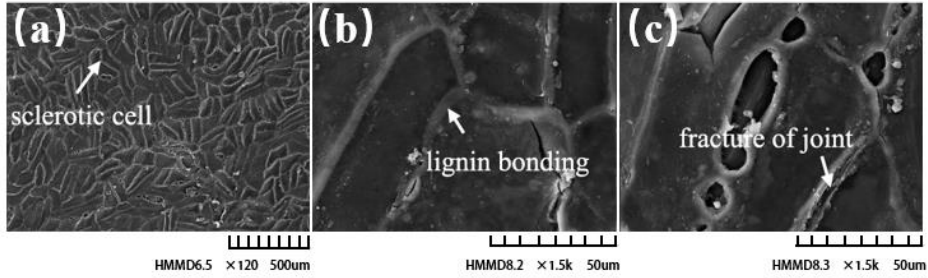
Figure 7. Scanned electron microscopic observation of seed shell. ( a ) Transverse section of seed shell (120, 500 μm). ( b ) Longitudinal section of seed shell (1500, 50 μm). ( c ) Seed shell rupture (1500, 50 (120, 500 µ m). ( b ) Longitudinal section of seed shell (1500, 50 µ m). ( c ) Seed shell rupture (1500, μm). 50 µ